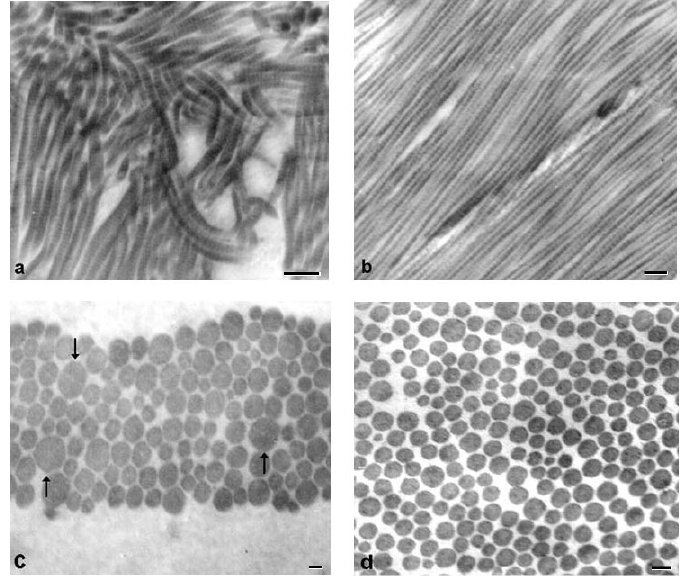
FIGURE 4. Electron micrographs of rat skin collagen: (a,c) treated with 1.5 meq Li/kg for 30 consecutive days. Animals were sacrificed 6 months after the last lithium injection. In (a) fibrils in disarray are shown while in (c) collagen fibrils with considerable variation in diameter are present. Such fibrils are significantly smaller than the untreated fibrils. Abnormally large fibrils (indicated by arrows) with an irregular elliptical profile are also present. (b) Normal skin fibrils packed in roughly parallel array. (d) Control fibril diameters for comparison. Bar = 0.6